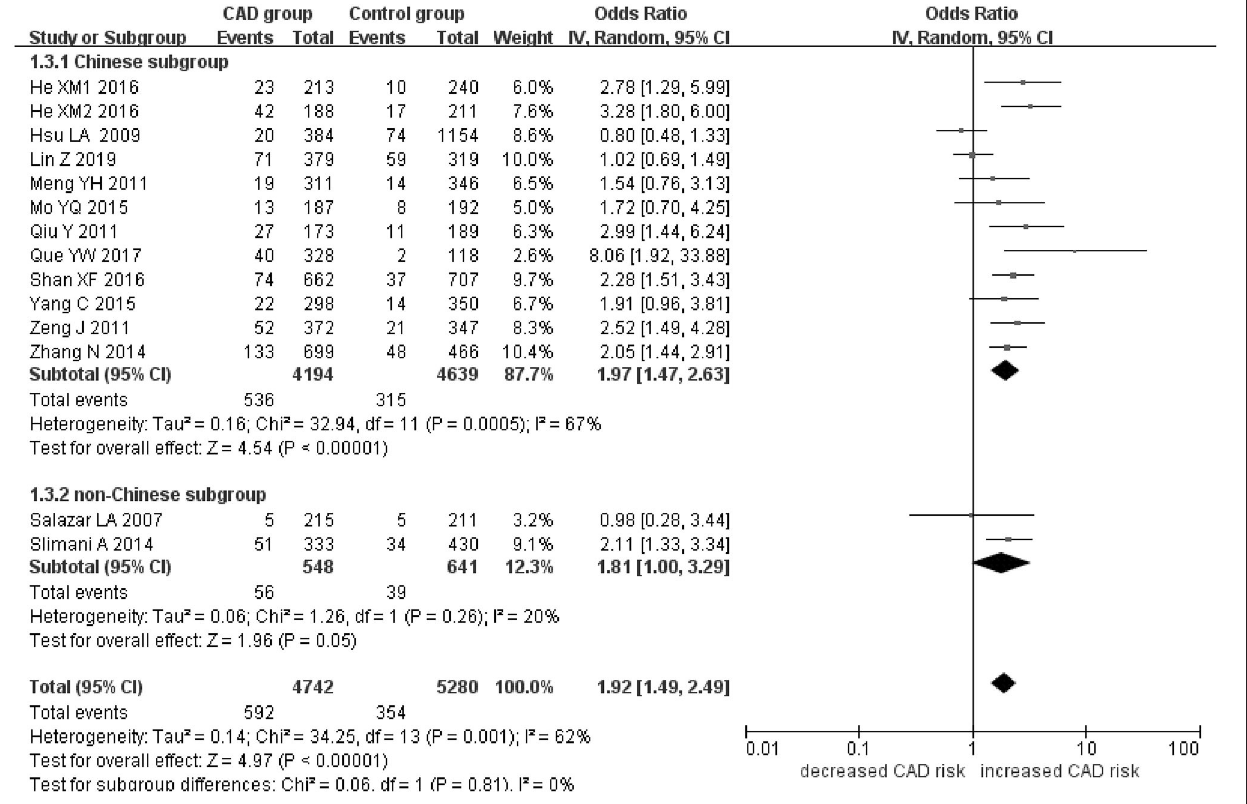
found heterogeneity to be limited to the Chinese group ( P heterogeneity < 0.05) with no heterogeneity found in the non-Chinese subgroup (P heterogeneity > 0.05). This suggests ( P heterogeneity <